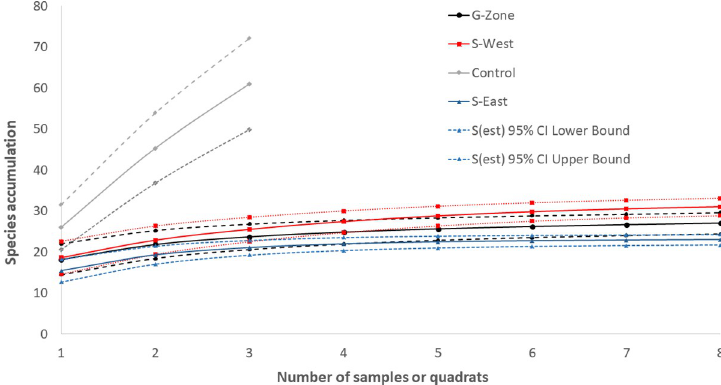
Fig 2. Rarefaction curves for overstorey tree species in three reclaimed mine lands and one control (natural forest) site. Straight lines represent species richness dash (-—-) or dotted ( ... ) lines indicate the 95% confidence interval for the lower and upper boundaries. G-Zone, S-West, and S-East represent the reclaimed sites.